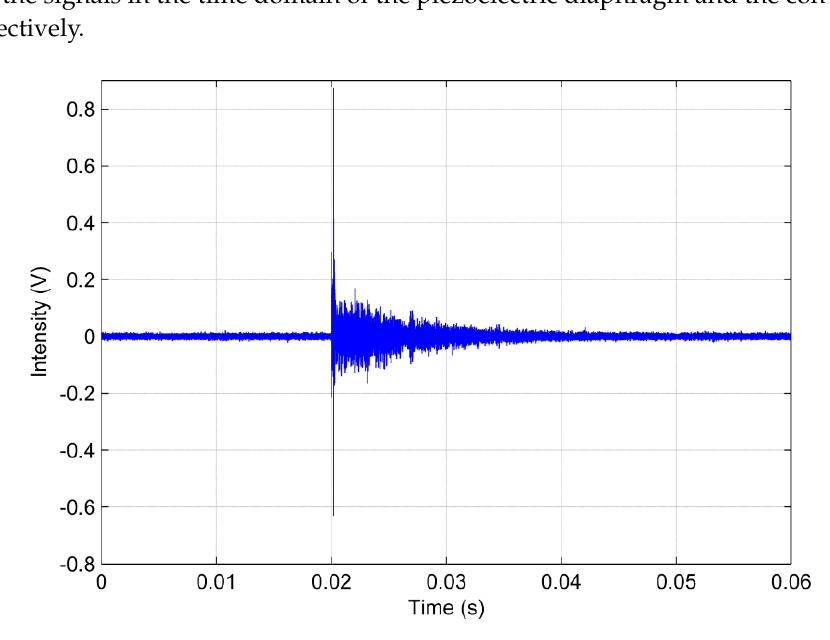
Figure 6. Partial discharge signal in the time domain obtained for the piezoelectric diaphragm.